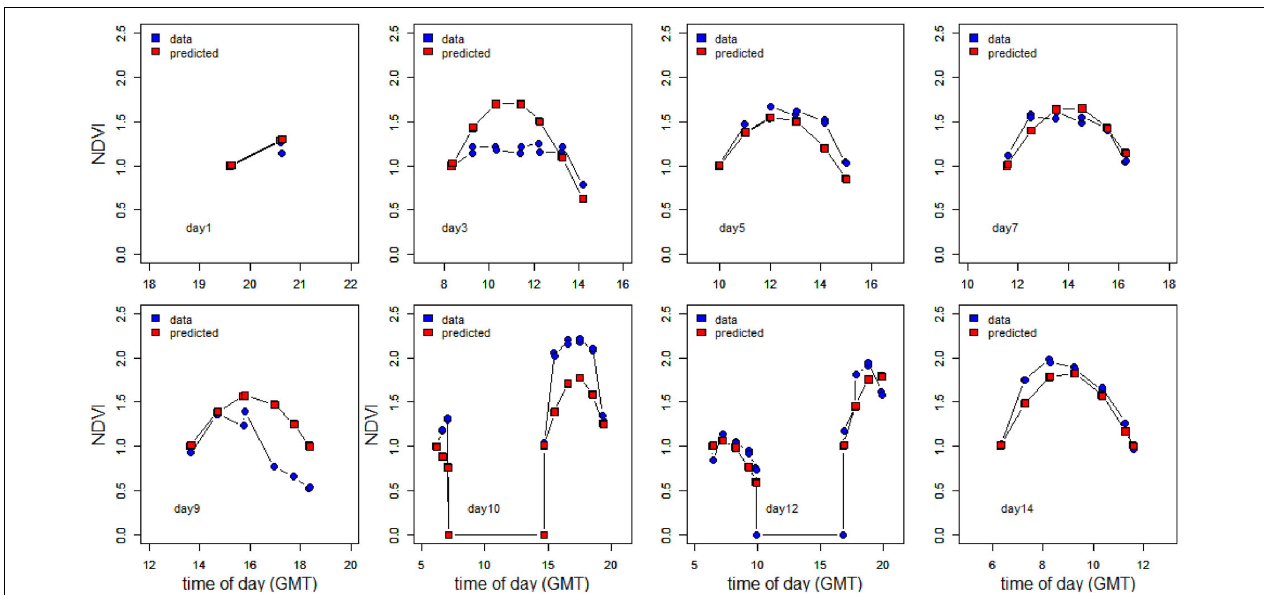
FIGURE 7 | Measured vs. predicted NDVI values. The NDVI values were normalized to the initial values measured immediately after emersion of the tidal flat.